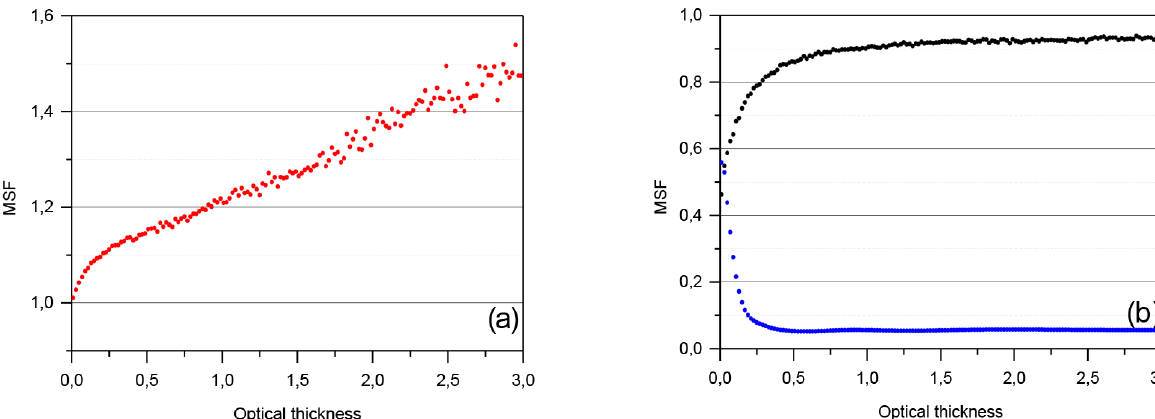
Figure A1. Multiple-scattering functions. (a) Red points G MS (h) , (b) black points η MS (h) and blue points F MS (h)